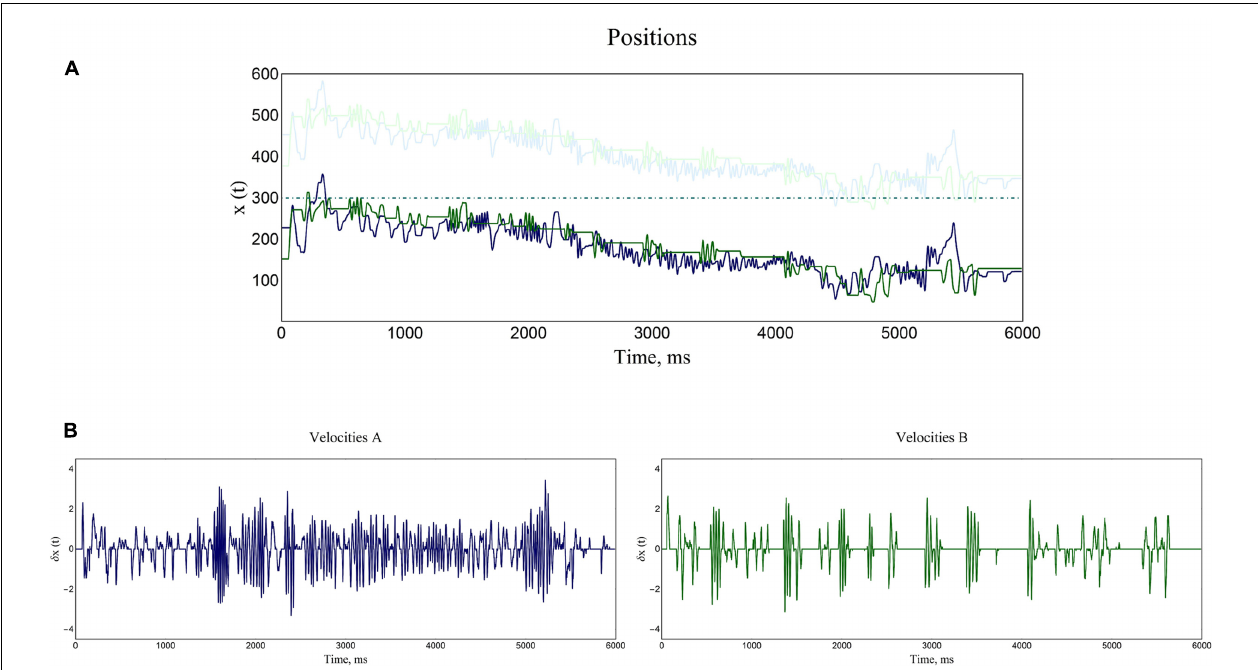
FIGURE 2 | Time-series of a representative trial. (A) Both participants’ positions are plotted, as well as the positions of the objects which they could encounter with (shadow objects and static objects). In this example an interactive turn-taking of movements is taking place, and a jointly drifting through the virtual space is conspicuous. (B) The instantaneous velocities (derivative of the players’ positions) are shown for both participants of the dyad. Notice that all the values oscillate around zero, meaning that there is no trend in this new